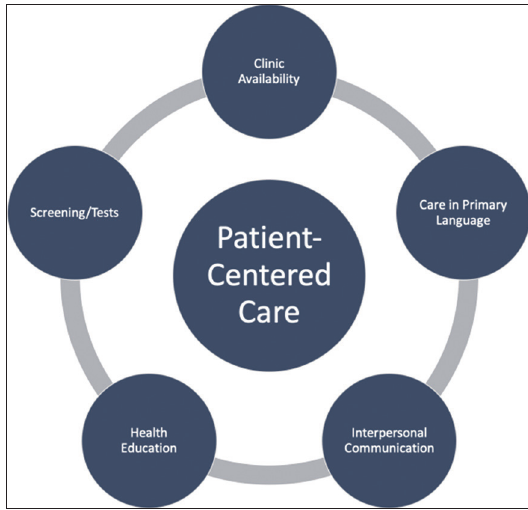
Figure 1: Patient-centered care. Overarching themes that emerged from the study